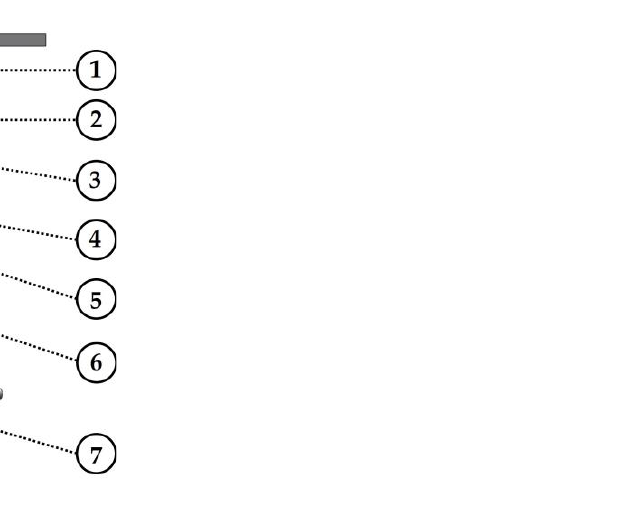
Table 1. Model and description of devices used in force-controlled actuators.